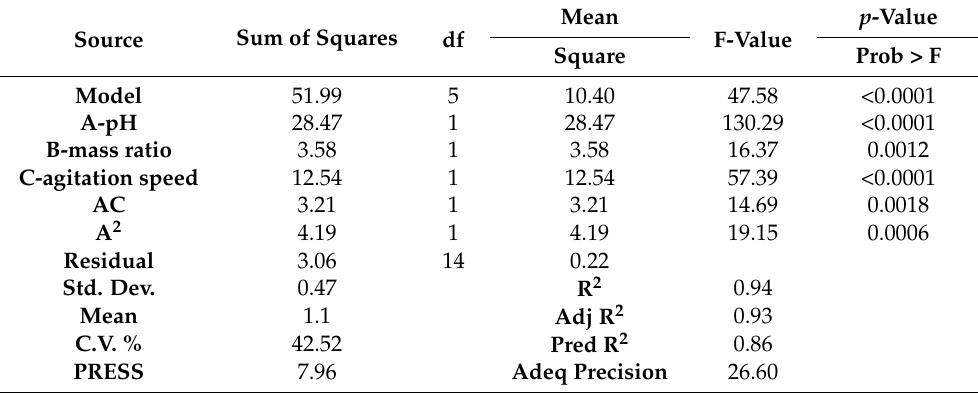
Table 3. Analysis of variance results for RSM model regarding harvesting process, where A is pH, B is mass ratio, and C is agitation